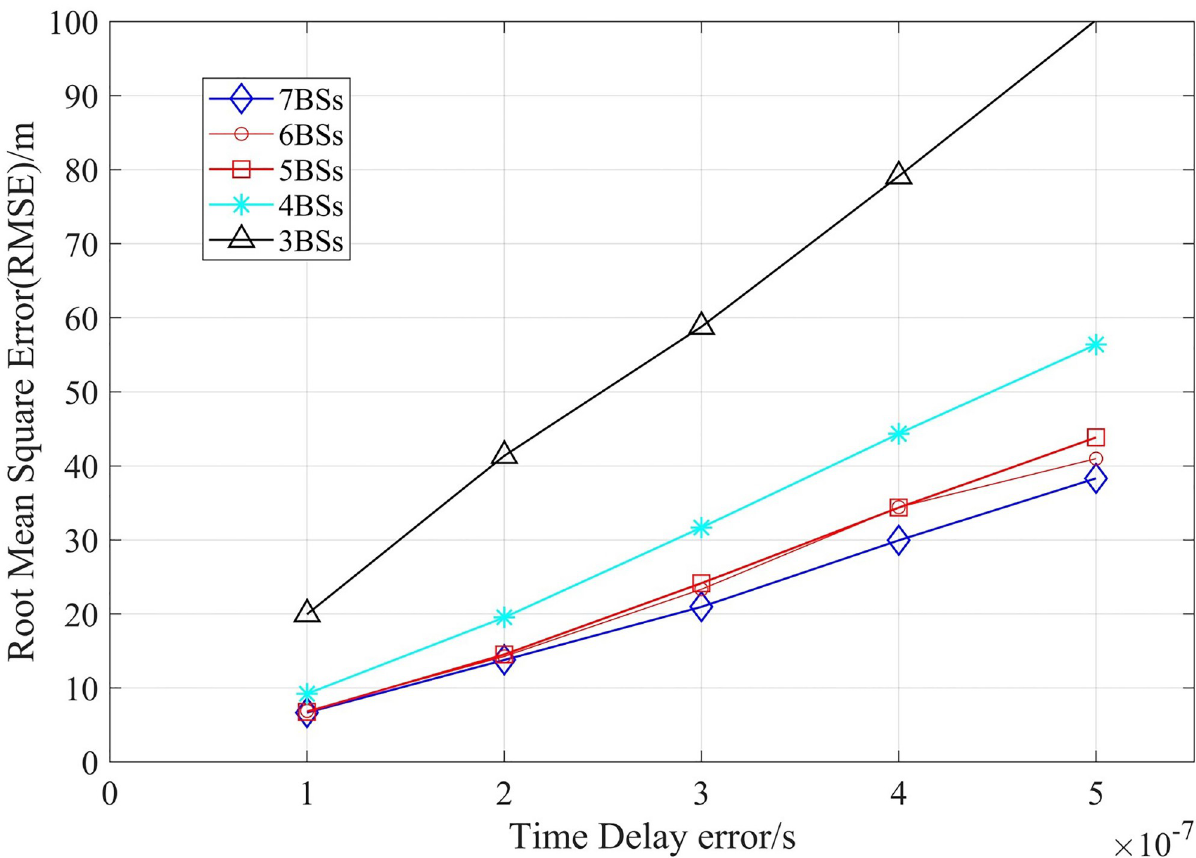
Fig 8. Comparison of positioning accuracy of different number of base